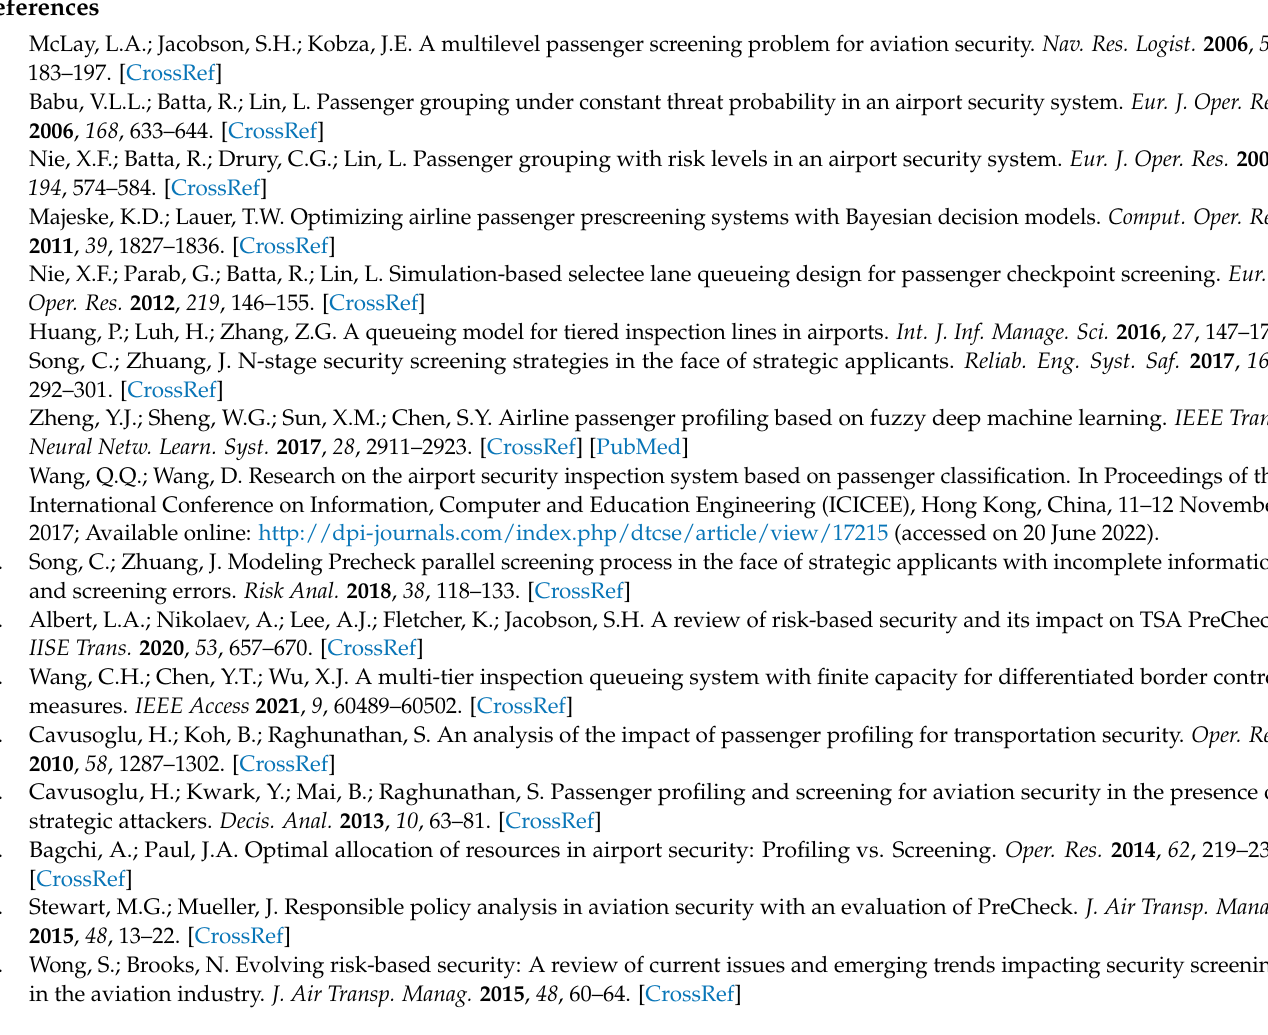
Figure A35. Single factor evaluation for the index of time of buying tickets (more than 14 days before departure).